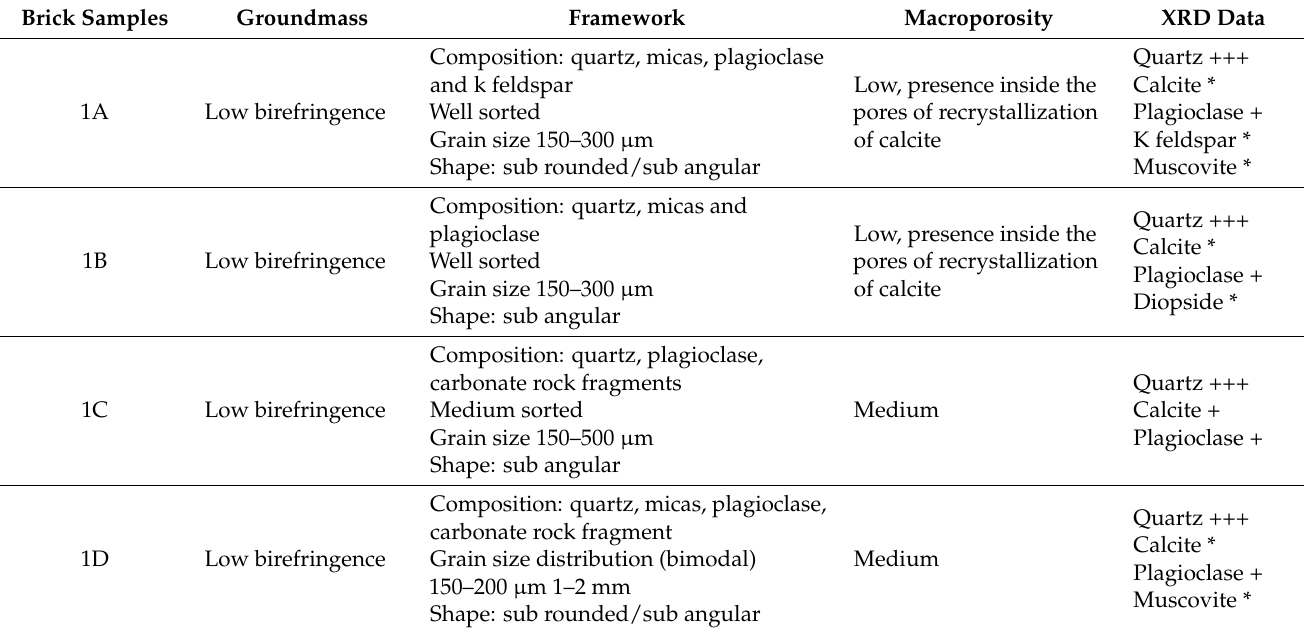
Table 5. Mineralogical composition (semiquantitative data) and petrographic description of